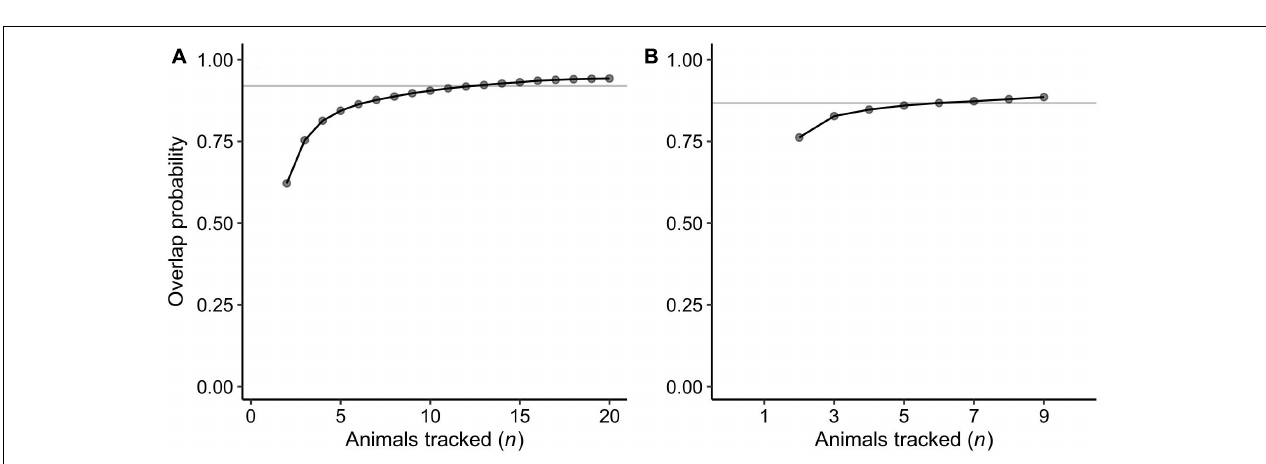
FIGURE 3 | Collective inter-nesting habitats (i.e., mean of all UDs) of green turtles that nested at (A) Jazirat Mashabah ( n = 20) and (B) Ras Al Baridi ( n = 9). Green line in panel (A) encloses the area managed by the Red Sea Development Company.